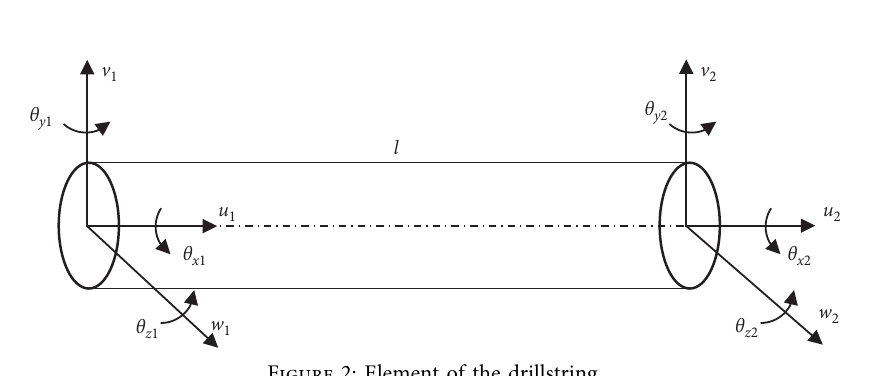
Figure 2: Element of the